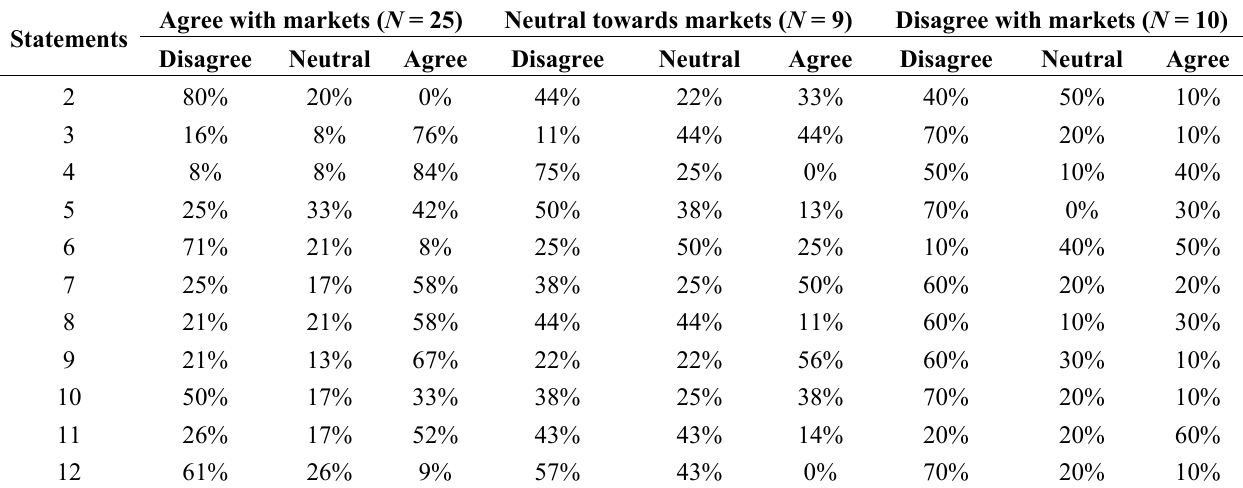
Table 3. Differentiated stakeholder responses according to their perception of a water market as a good idea (No. of respondents: N =